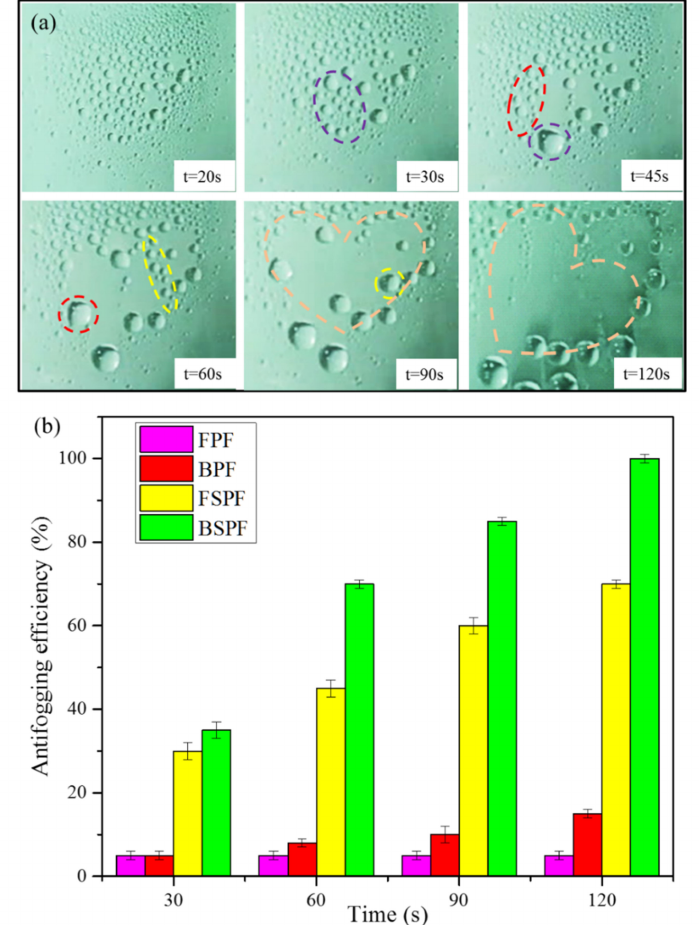
Figure 10. ( a ) Optical images show that the macro-dynamic process of fog drops movement on the BSPF surface. From t = 20 s to t = 120 s, with water condensation, some tiny fog drops began to merge with each other and form larger fog drops (the same color outline from t = 20 s to t = 120 s). As the fog drops reach a certain size, the fog drops begin to slide off the BSPF by gravity-driven and take away some tiny fog drops along the way (see orange heart-shaped outline at t = 120 s); ( b ) the graph of antifogging efficiency on the resultant surfaces. At t = 120 s, the maximum antifogging efficiency for BSPF surface is close to 100%, while the antifogging efficiency for FPF, BPF and FSPF are about 35%, 70% and 85%,